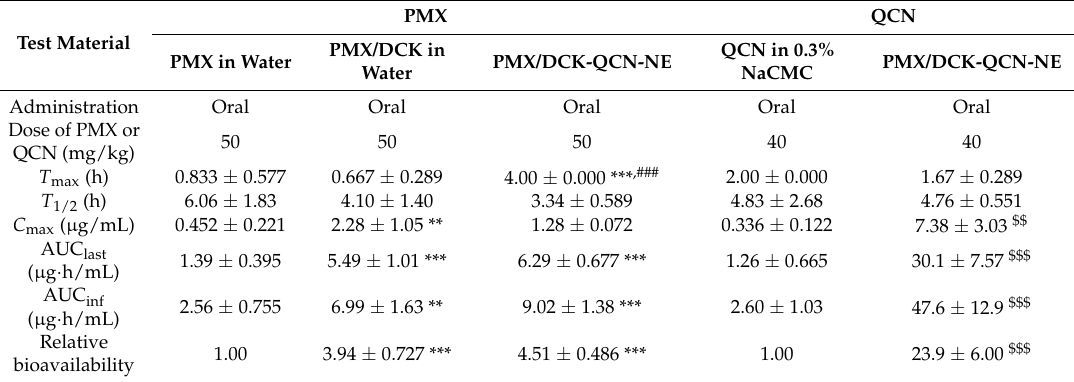
Table 2. Pharmacokinetic parameters of PMX and QCN in rats after oral administration of PMX, QCN in 0.3% NaCMC, or